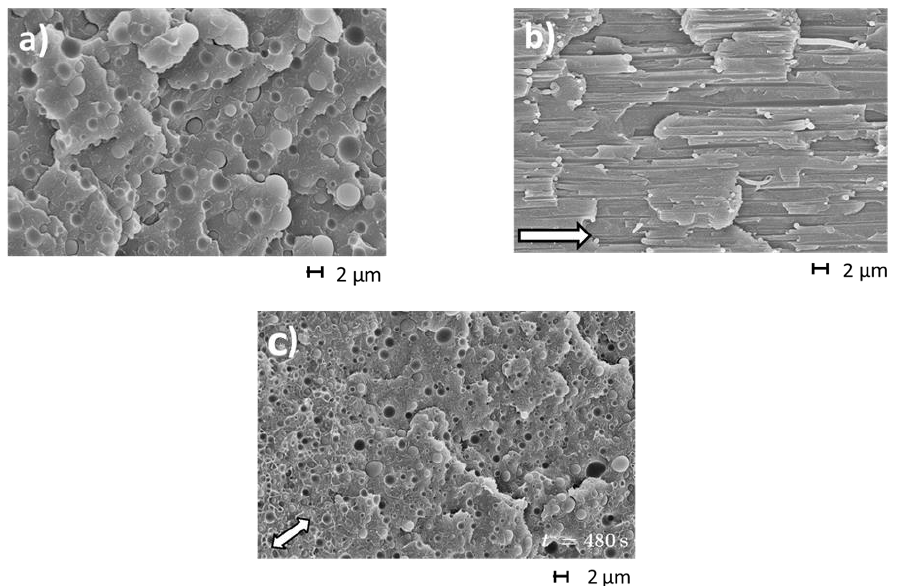
Figure 17. Scanning electron micrographs of the blend PS/LLDPE 85/15 ( a ) before stretching, ( b ) in the elongated state at 𝜆 = 12 and ( c ) after recovery for 480 s at 170 °C. The sample was deformed at the extensional rate 𝜀 ̇ = 0.1 s −1 and 𝑇 = 170 °C. The arrows indicate the stretching direction [31].